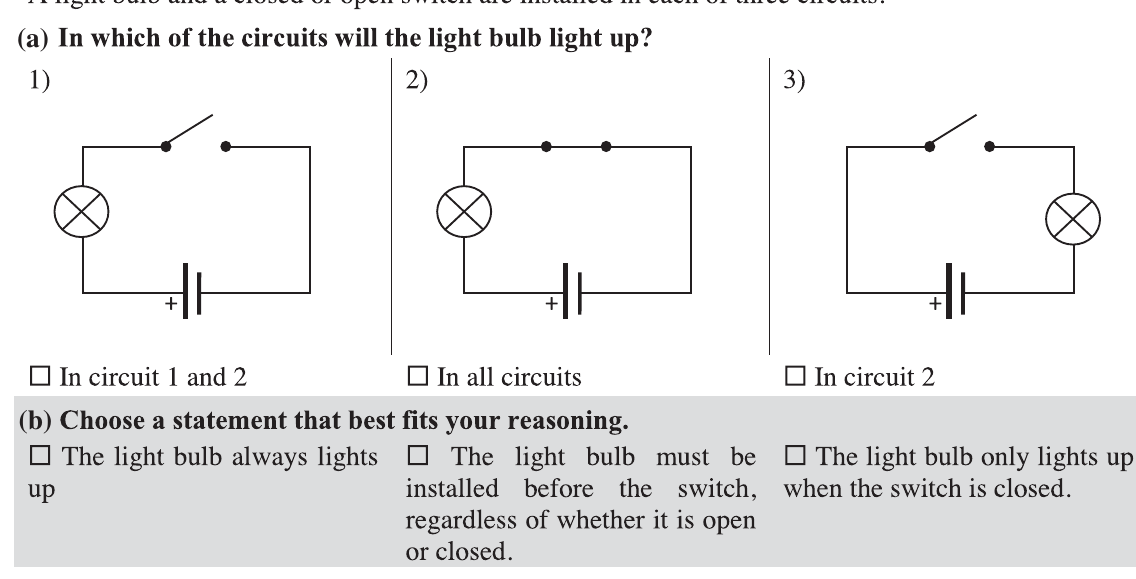
FIG. 7. Representation of Item 1 in test